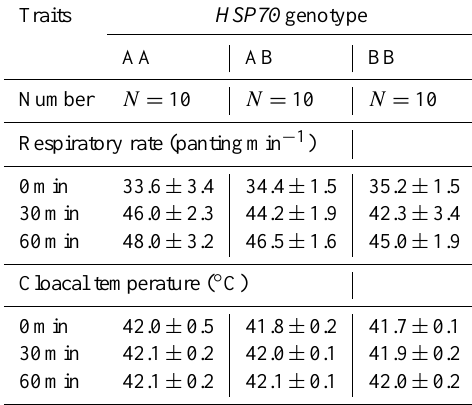
Table 2. The effect of HSP70 genotypes on respiratory rate and cloacal temperature of the LRI native chickens at 40 ◦ C ambient